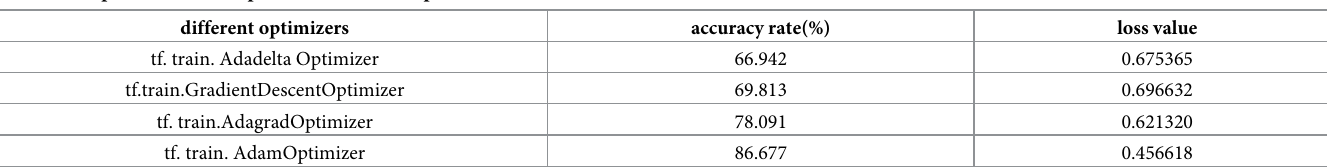
Table 7. The performance comparison of different